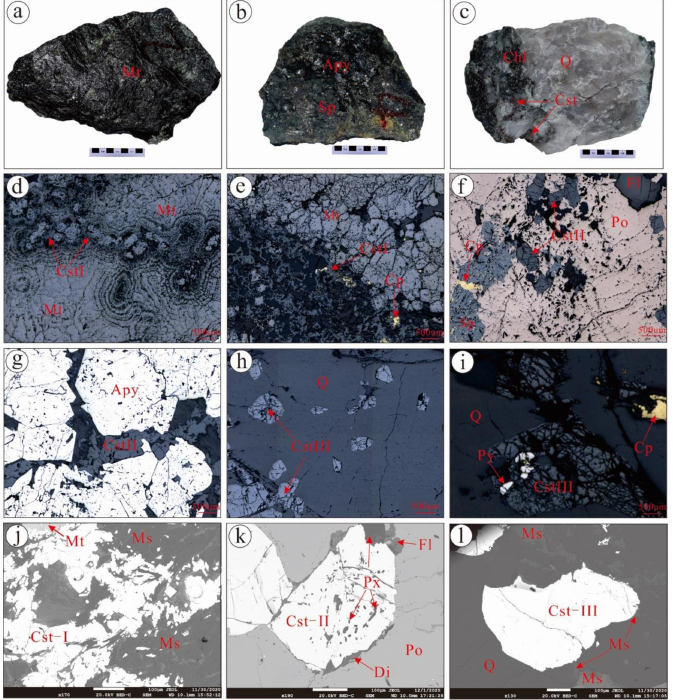
Figure 3. Photographs, photomicrographs, and BSE image of tin ores from the Dulong district. ( a ) Cassiterite-magnetite ± sulfide ore. ( b ) Cassiterite-sulfide ore within the proximal skarn. ( c ) Cassiterite-quartz vein ore. ( d ) Photomicrographs of cassiterite-iron ± sulfide (Cst I). ( e ) Cassiterite intergrowth with magnetite and chalcopyrite. ( f ) Photomicrographs of cassiterite-sulfide (Cst II). ( g ) Cassiterite intergrowth with pyrrhotite, sphalerite, and arsenopyrite. ( h ) Photomicrographs of cassiterite occurs in quartz vein. ( i ) Cassiterite in quartz vein intergrowth with chalcopyrite and pyrite. ( j ) BSE image of Cst I intergrowth with muscovite. ( k ) BSE image of Cst II intergrowth with pyroxene and diopside. ( l ) BSE image of Cst III overgrowth with muscovite and quartz. Abbrevi- ations: Cst = cassiterite, Mt = magnetite, Cp = chalcopyrite, Apy = arsenopyrite, Po = pyrrhotite, Fl = fluorite, Px = pyroxene, Di = diopside, Py = pyrite, Q = quartz, Sp = sphalerite, Ms =